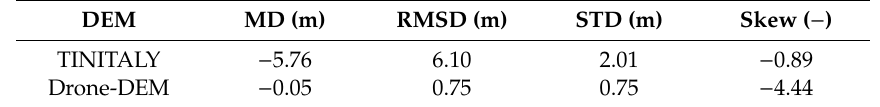
Table 2. Difference metrics of the TINITALY and Drone-DEM with respect to the LiDAR 1 . DEM MD (m) RMSD (m) STD (m) Skew ( − ) TINITALY − 5.76 6.10 2.01 − 0.89 Drone-DEM − 0.05 0.75 0.75 − 4.44 (STD), Skewness (Skew).